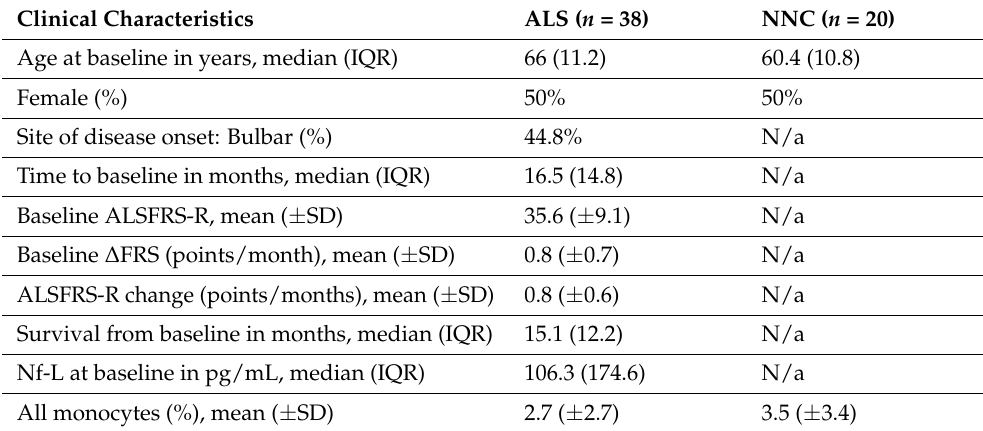
Table 1. Demographic and clinical characteristics of study participants.